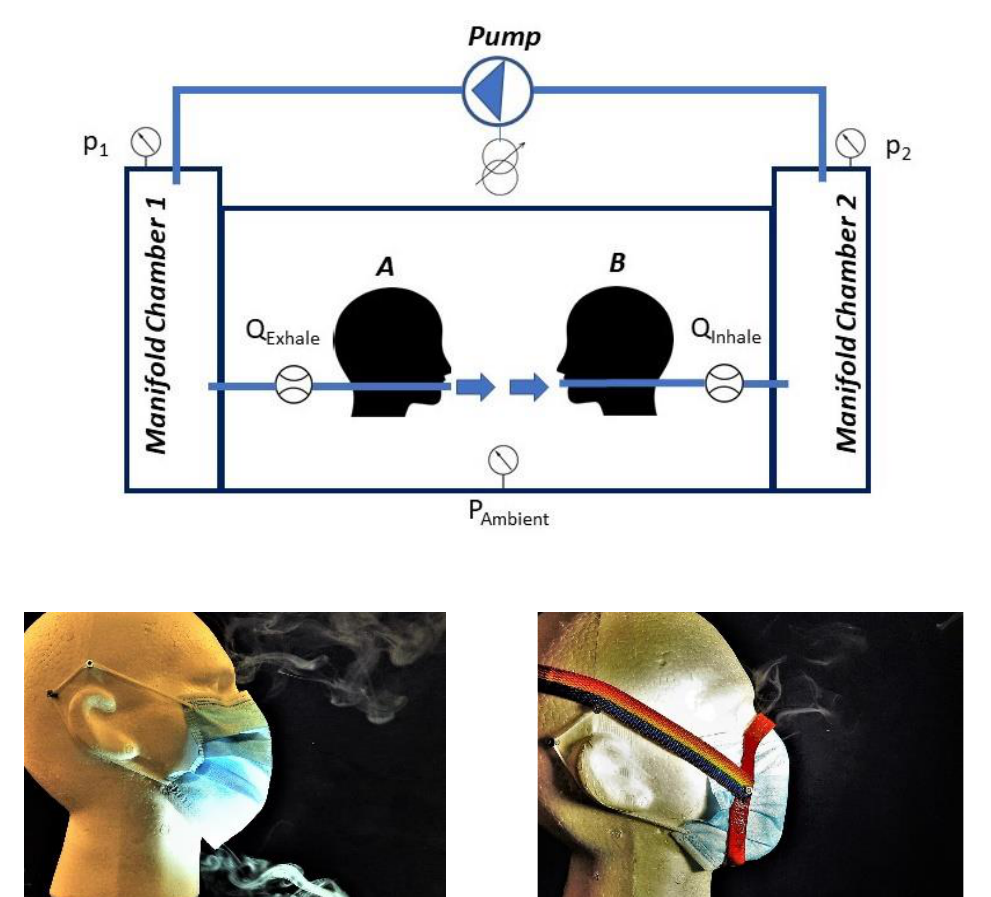
Figure 1. Upper: test facility with mannequin heads for exhalation (A) and inhalation (B) on which masks are mounted. Air flow rate was regulated by a variac transformer driving an air pump and measured by flow meters placed in pipes between chambers and mouth regions, and chamber pressures measured by pressure manometers. Lower: surgical face mask M1 mounted on mannequin’s face ‘casual’ ( left ) and ‘tight’ by use of the GRP fitter ( right ) where leak flows visualized by e-cigarette smoke show chin and nose leaks ( left ) and nose leak ( right ).